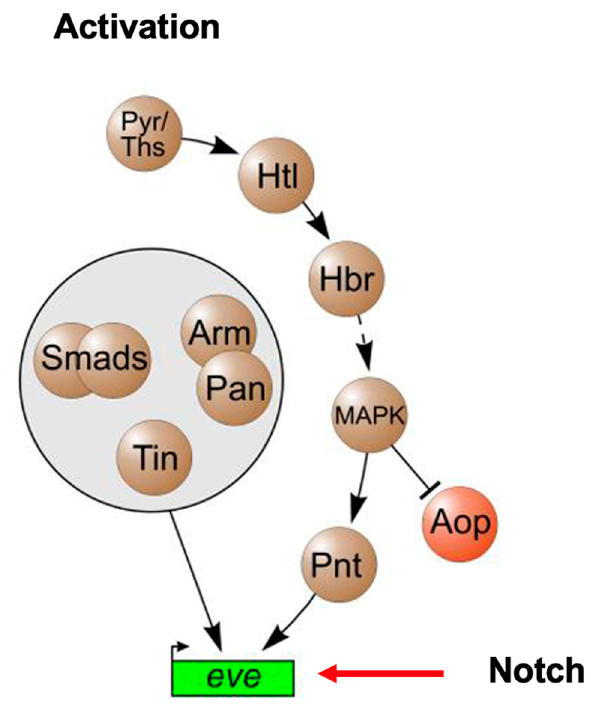
Figure 6. Cardiac mesoderm activation pathways in Drosophila heart development (adapted from